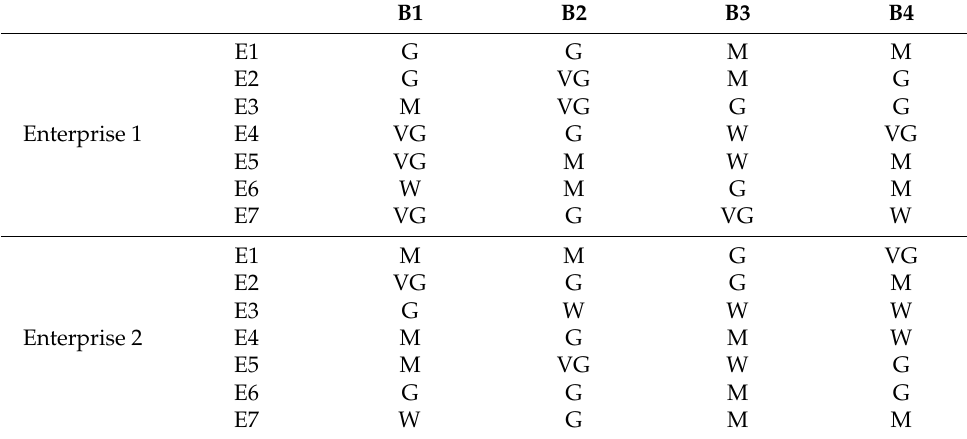
Table 4. Expert language evaluation values of the secondary indicators of energy conservation and carbon reduction (B) of the six evaluated